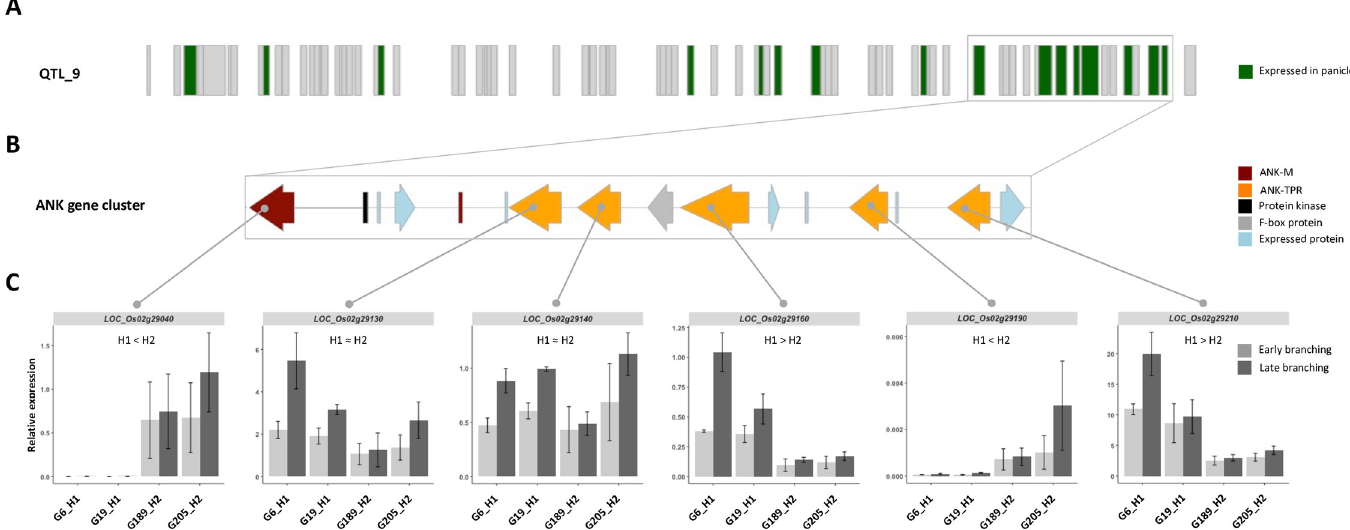
Fig 3. Structure of the ANK and ANK-TPR gene cluster in QTL_9 and expression profiling. (A) Schematic view of the annotated genes according to the O . sativa ssp . japonica cv. Nipponbare MSU7.0 reference genome in the 780 Kbp region corresponding to QTL_9 showing genes that are expressed (green) or not expressed (grey) in the developing panicle according to publicly available databases and RNA-seq datasets. (B) Schematic view of the cluster of ankyrin genes in the 3’ proximal region of QTL_9 with annotated genes shown based on the O . sativa ssp. japonica cv. Nipponbare MSU7.0 reference genome. The orientation of the genes is indicated by arrows. (C) Histograms of expression profiling by qRT-PCR of the 6 ANK and ANK-TPR genes in two accessions from H1 haplotypes (G6 and G19) and two accessions from H2 haplotypes, based on two panicle developmental stages: “early branching” and “late branching”. Data are given as means ± SD.